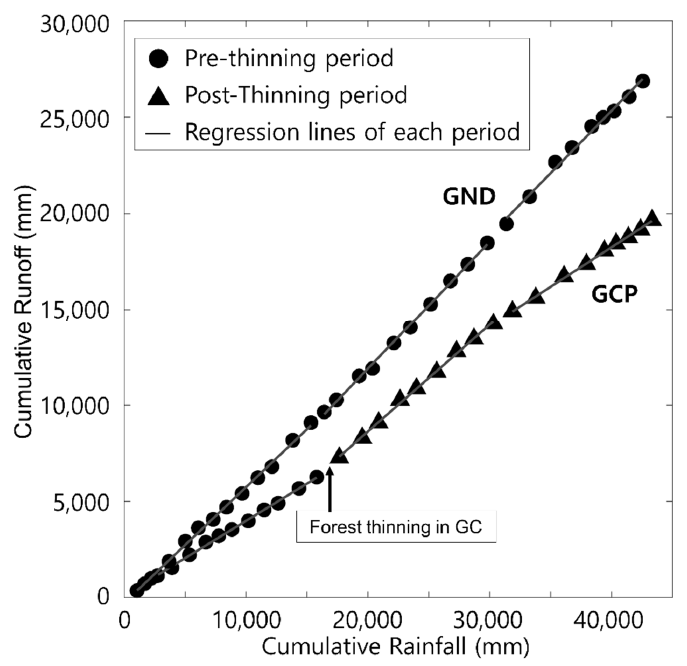
Figure 3. Double mass curves of GCP and GND forest catchments.